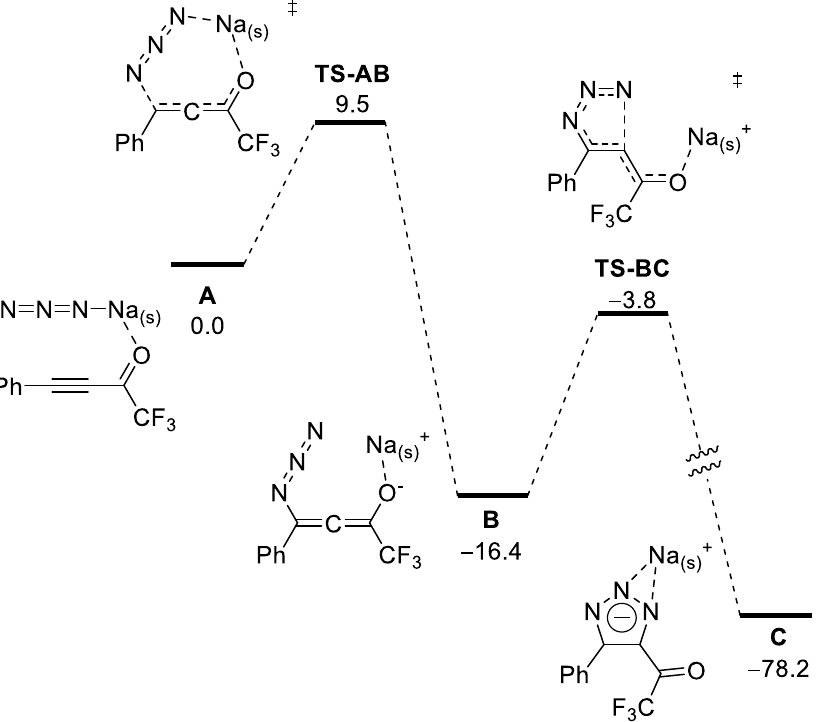
Scheme 3. Plausible DFT mechanism of formation of triazoles in absence of acid (numbers are relative Gibbs free energies in kcal/mol; Na (s)+ = Na(EtOH) 4+ ). Hydrogen azide and acetic acid have virtually the same pKa values (in water), at 4.75